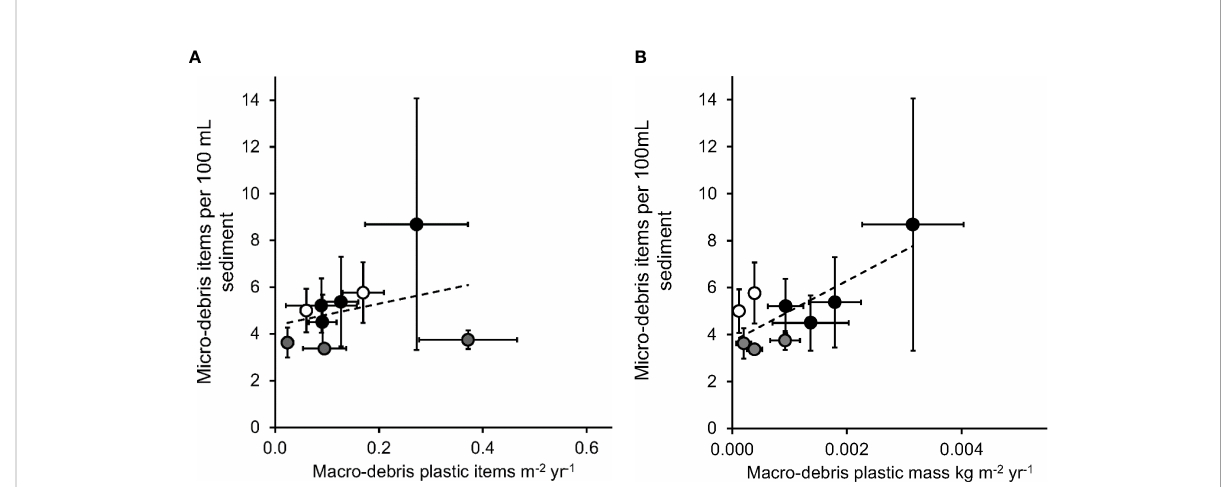
FIGURE 5 Mean plastic macro-debris item count (A) (items m -2 year -1 ) and mass (B) (kg m -2 year -1 ) (Mean ± SE) have non-signi fi cant positive relationships with the mean number of micro-debris items per 100mL of sediment (Mean ± SE) at sites on Santa Rosa Island (dark grey symbols), Santa Cruz Island (light grey symbols) and the California mainland (white symbols) (n =